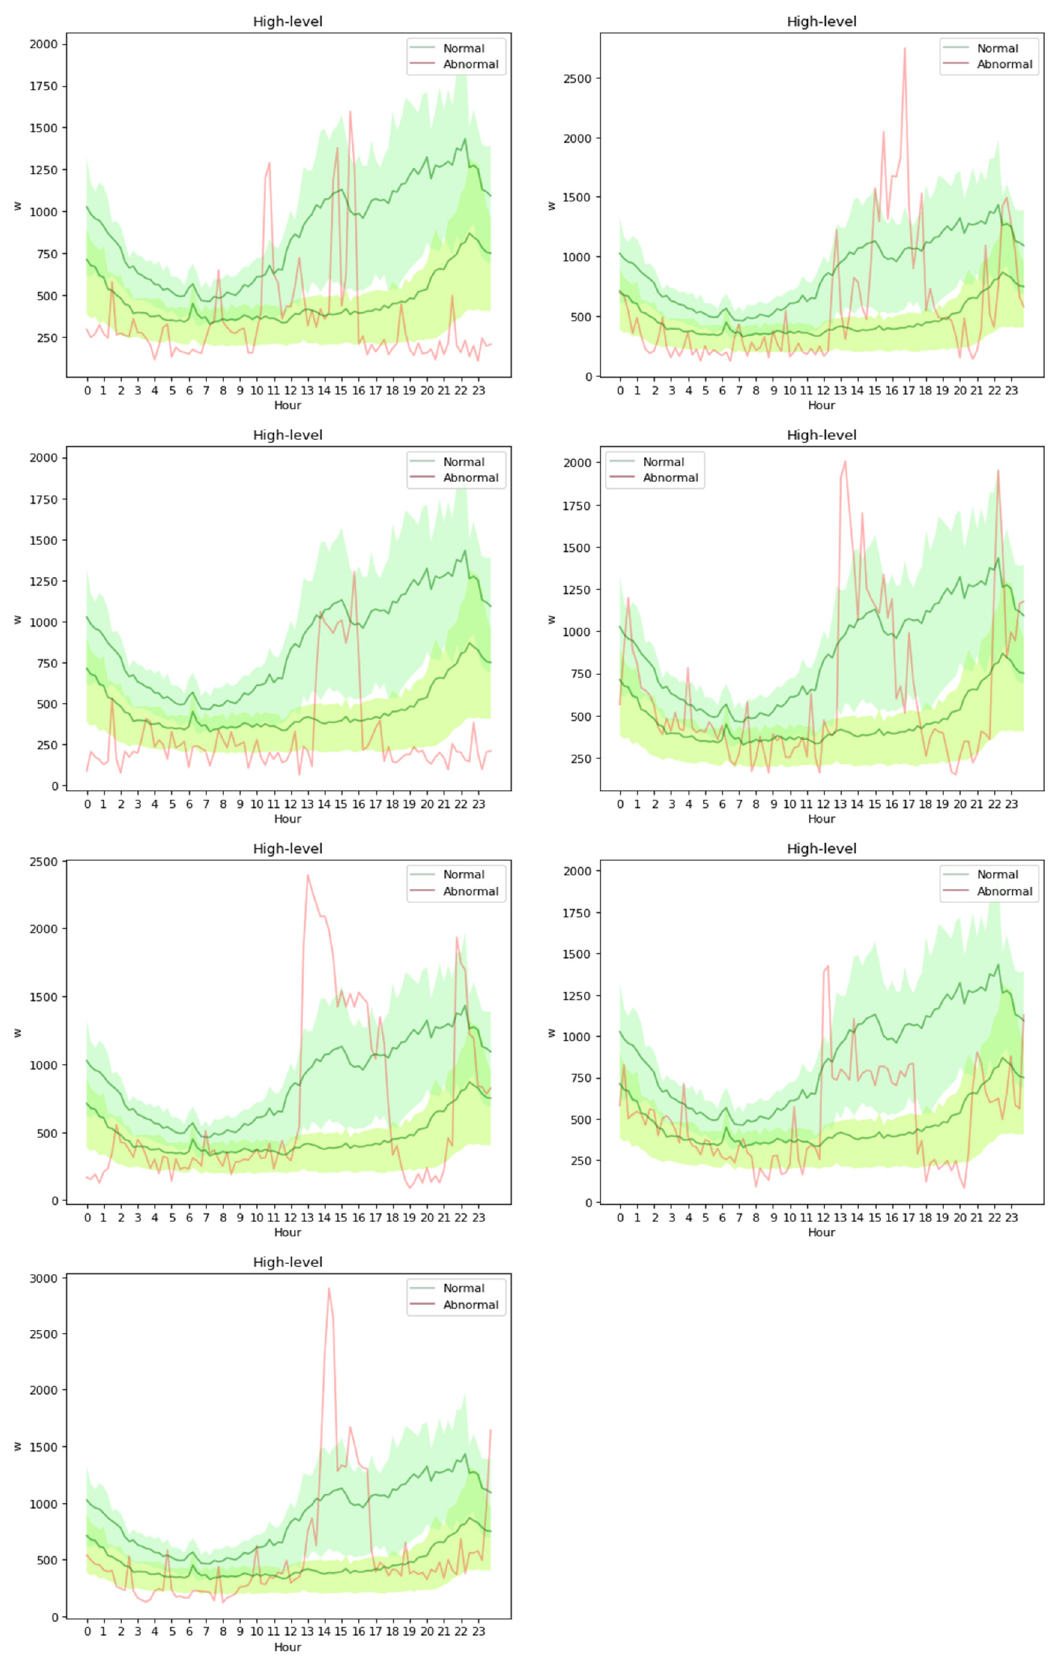
Figure A4. Load profiles of each abnormal electricity consumption events of User 02 using the high-level features.